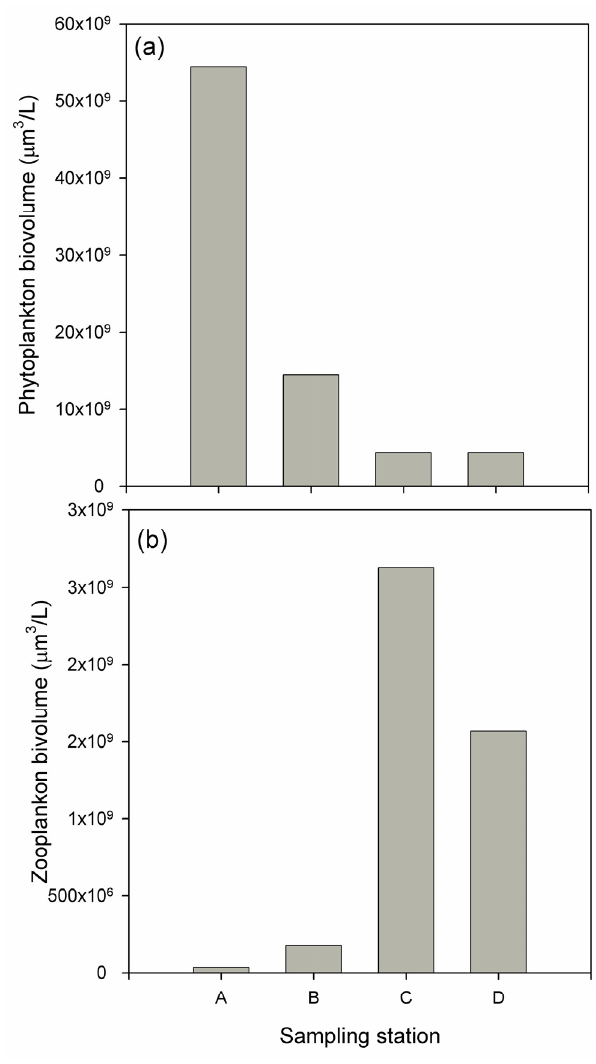
Figure 3. Longitudinal profile of: ( a ) Phytoplankton biovolume 5–100 μ m ESD; ( b ) Zooplankton biovolume 250–1000 μ m ESD.